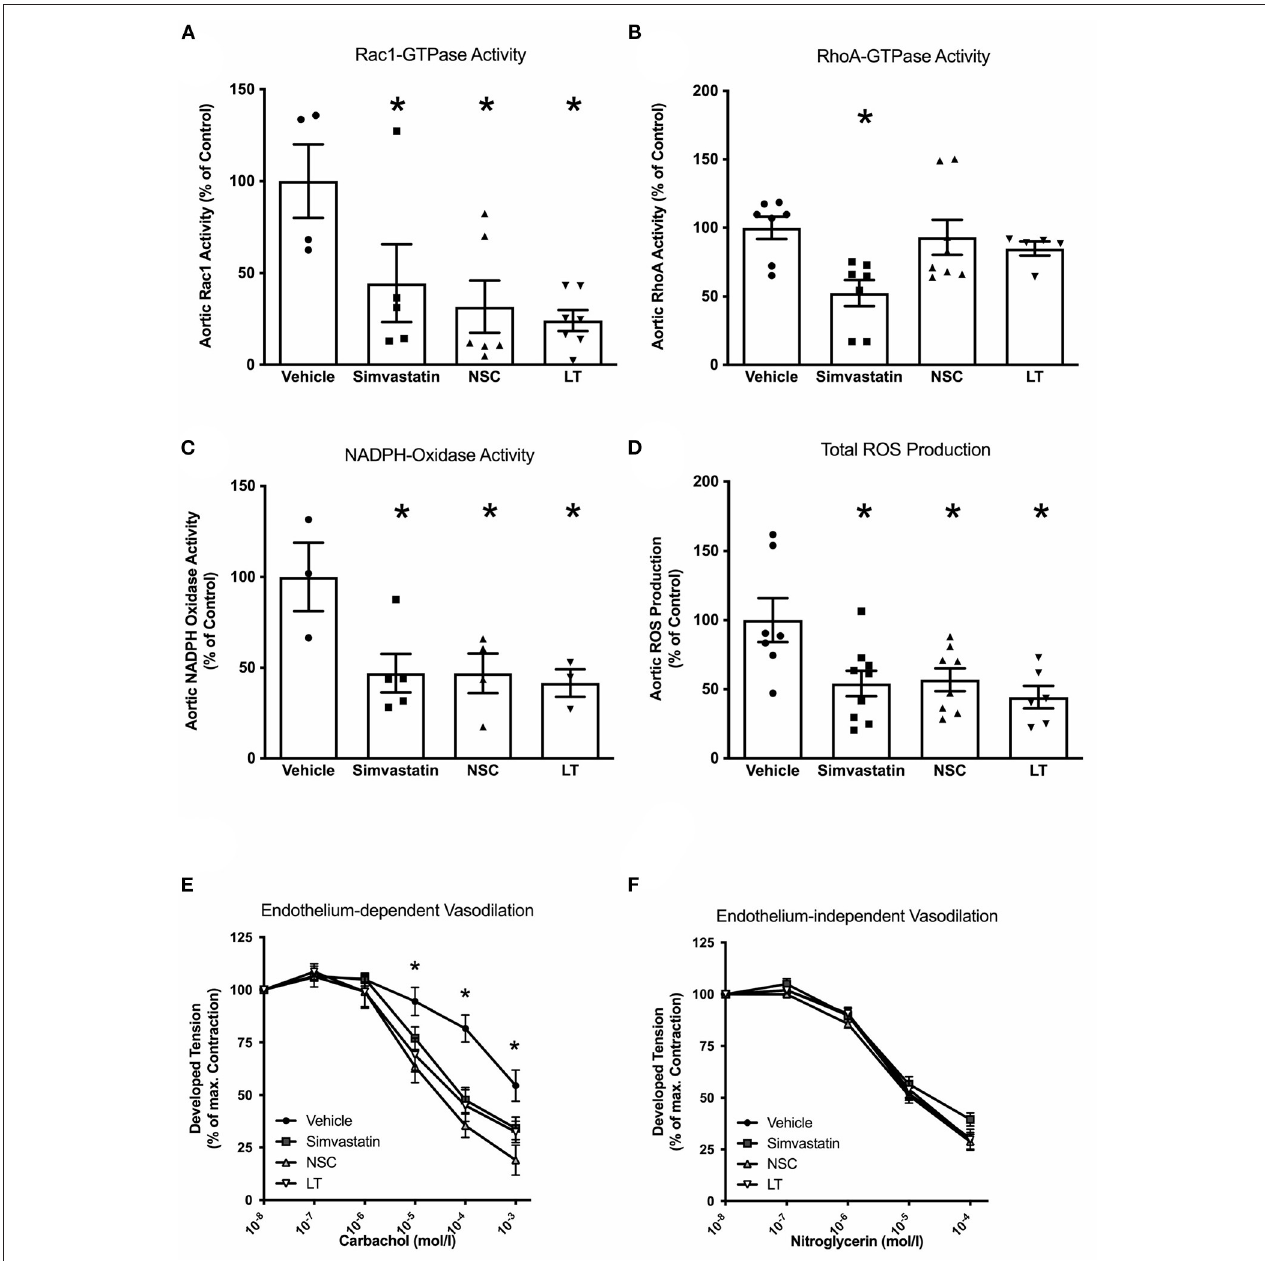
FIGURE 4 | Vascular effects of different Rac1 inhibitors: GTPase activity, oxidative stress and endothelial function. To investigate the vascular effects of different Rac1 GTPase inhibitors, ApoE − / − mice were fed a cholesterol-rich diet for 7 weeks and were concomitantly treated with vehicle, LT (0.1 µ g LT/week), NSC 23766 (10 mg/kg/d), or simvastatin (20mg activated simvastatin/kg/d). All three compounds significantly inhibited aortic Rac1 GTPase activity ( A , Rac1 GTPase activity G-LISA, * p < 0.05 vs. vehicle, n = 4–7 per group), but only simvastatin significantly decreased aortic rhoA GTPase activity ( B , rhoA GTPase activity G-LISA, * p < 0.05 vs. vehicle, n = 5–8 per group). All three compounds significantly reduced aortic NADPH oxidase activity ( C , lucigenin-enhanced chemiluminescence, * p < 0.05 vs. vehicle, n = 3–5 per group) and aortic ROS production ( D , L-012 chemiluminescence, * p < 0.05 vs. vehicle, n = 6–9 per group) and significantly improved endothelium-dependent vasodilation ( E , organ chamber experiments with isolated aortic segments, * p < 0.05 vs. vehicle, n = 5 per group) compared to vehicle-controls. Endothelium-independent vasodilation was not affected by the Rac1 inhibitors ( F , n = 5 per group).